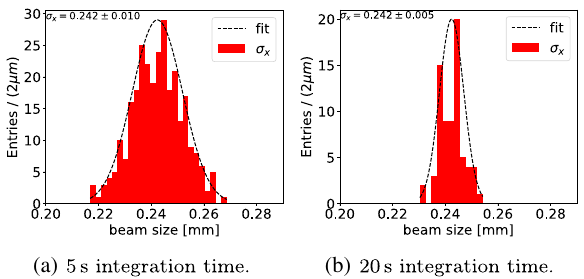
FIG. 15. Transverse beam size measurements for the BGV (blue squares) and BSRT extrapolated to the BGV location (red circles) for three different beam